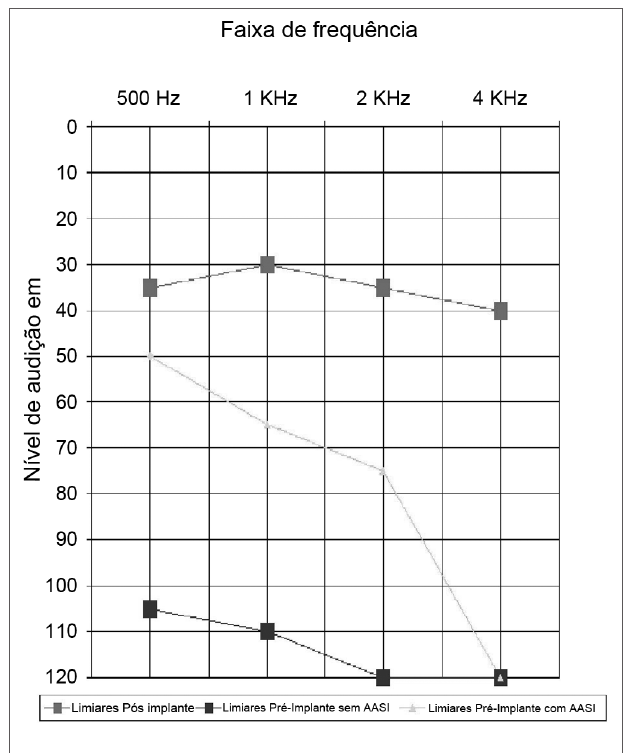
Figura 1. Resultados obtidos nas audiometrias em campo livre, pré e